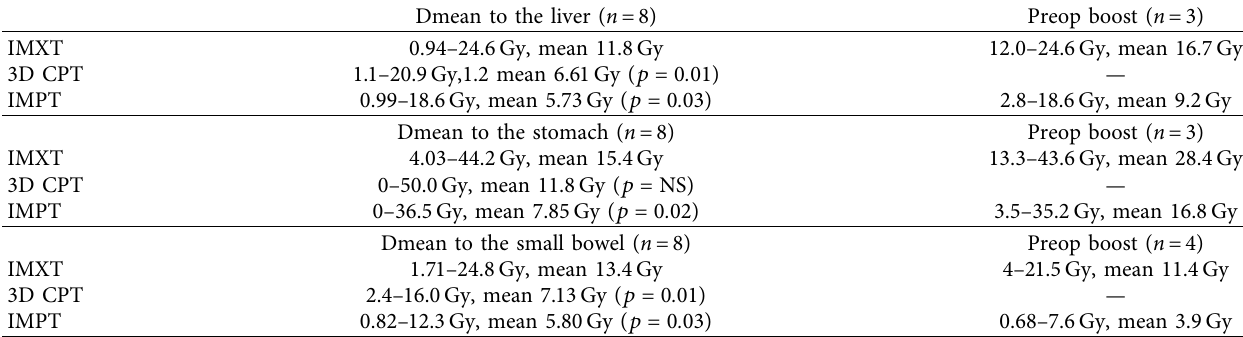
Table 4: Dose to organs at risk.